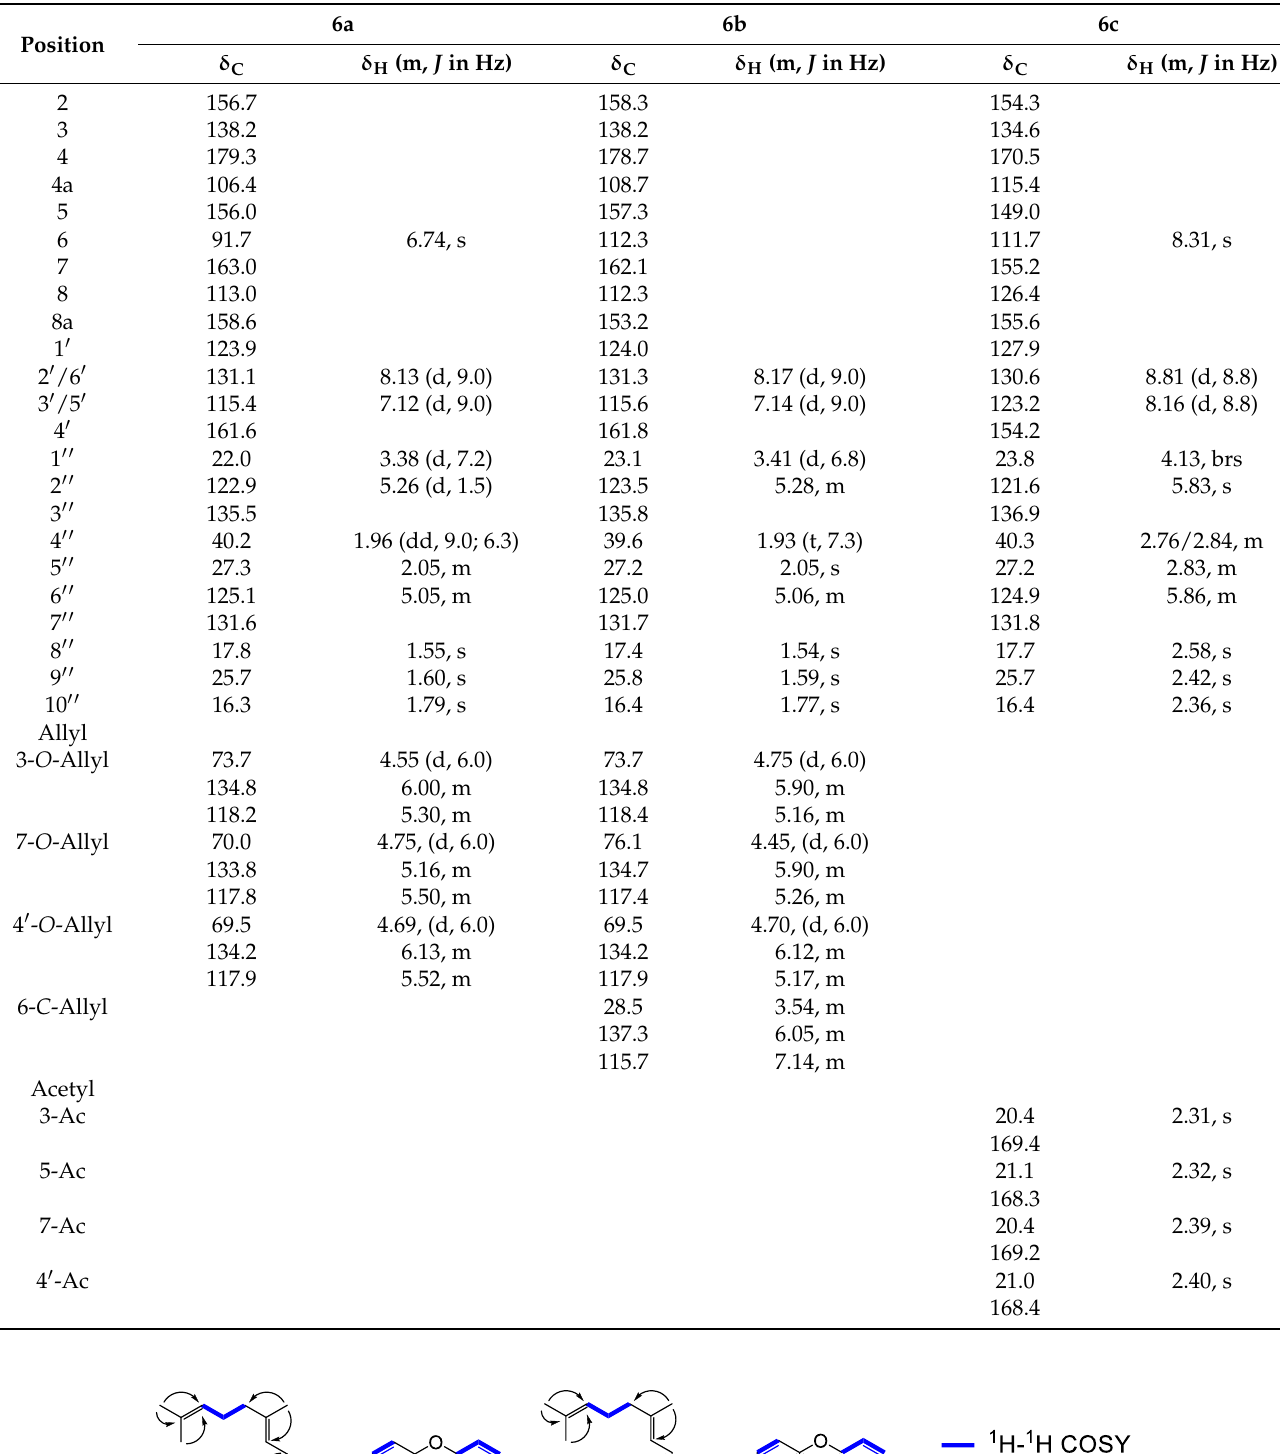
Table 2. 13 C and 1 H-NMR spectroscopic data of compounds 6a–c ( 1 H 500 MHz, 13 C 125 MHz in acetone – d 6 ).